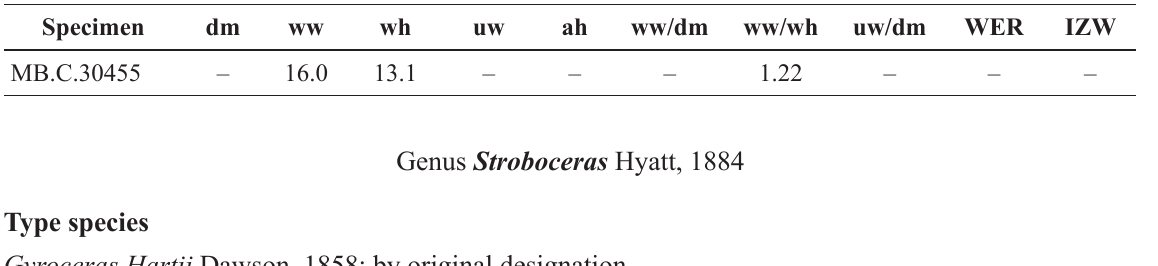
Table 4. Conch dimensions (in mm) and ratios of Stroborineceras